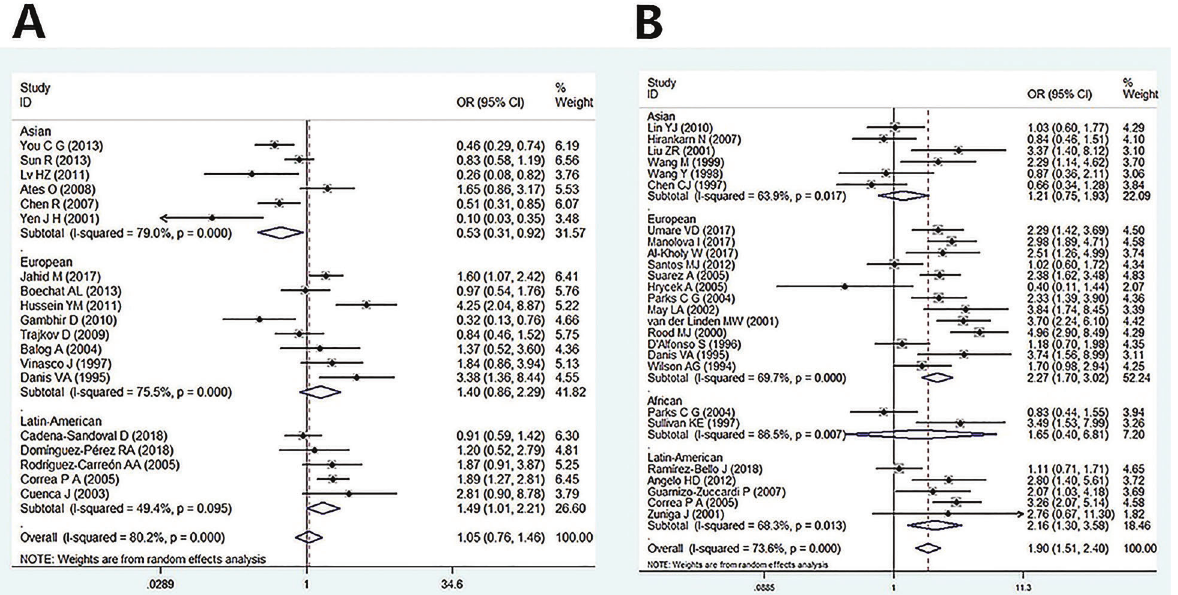
Figure 3. Forest plot for the correlation between TNF- a -308 and rheumatoid arthritis (A) and systemic lupus erythematosus (B) risk.